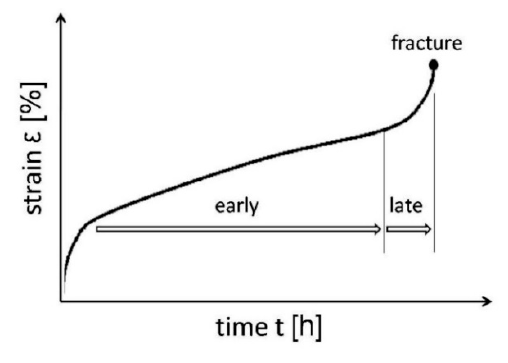
Figure 1. Creep curve.